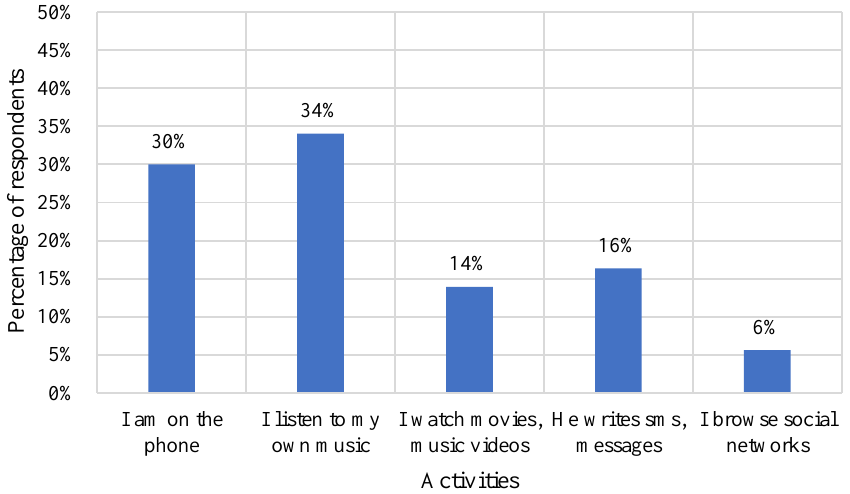
Figure 7. Characteristics of the respondents in terms of the most frequently performed activity on a mobile phone when crossing a pedestrian crossing.